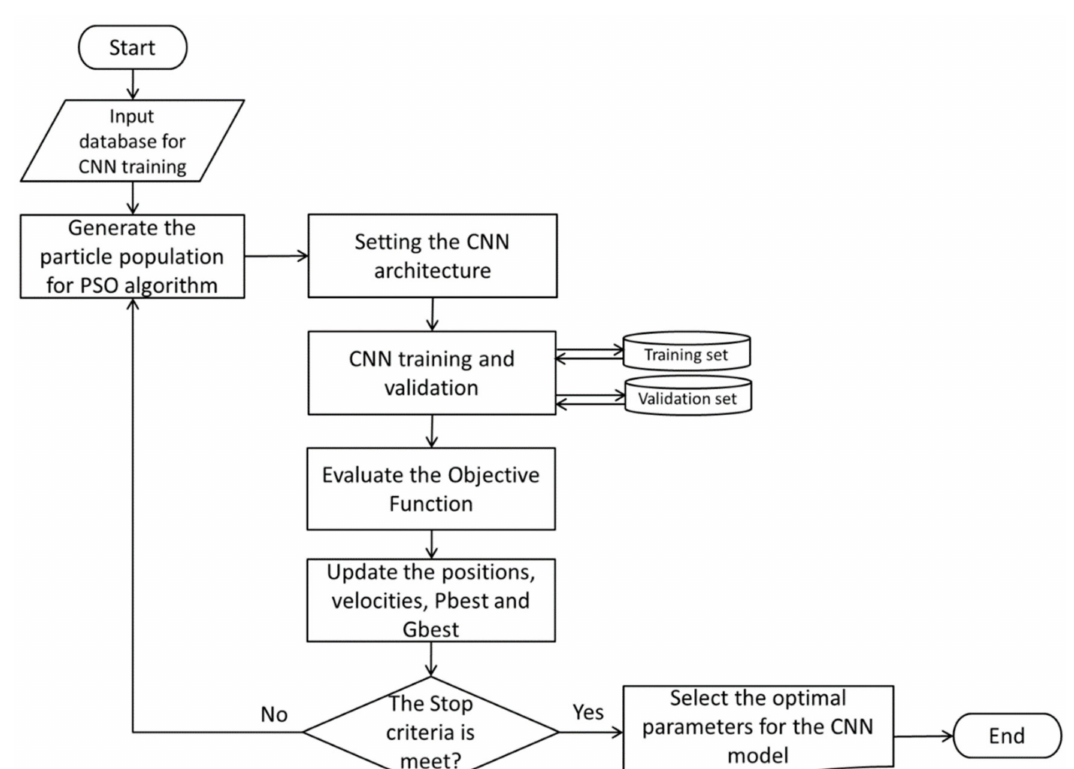
Figure 7. Flowchart of CNN optimization process using